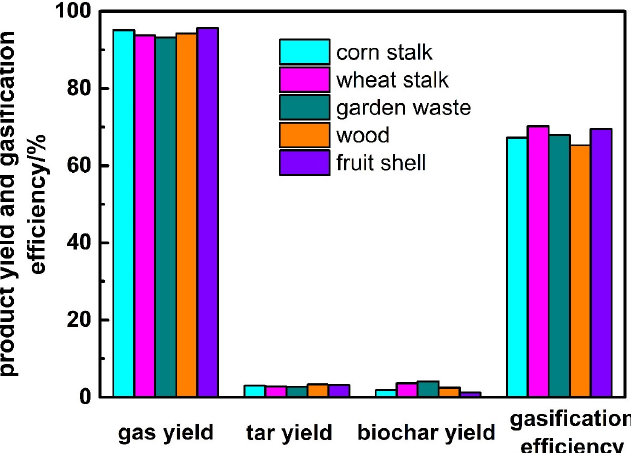
Figure 6. Effect of biomass types on product yield and gasification efficiency.